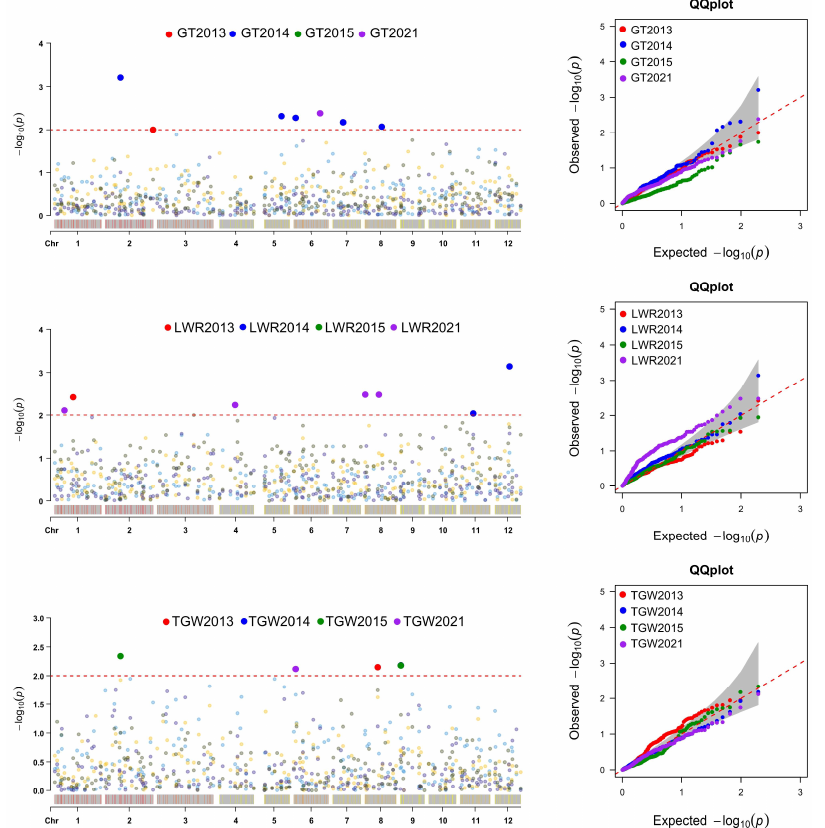
Figure 4. Manhattan plots and quantile–quantile (QQ) plots for grain-size traits based on the MLM model. For the Manhattan plot, the x-axis presents the 12 rice chromosomes and the y-axis the LOD ( − log( p -value)) values. For the QQ plot, the x-axis presents LOD ( − log( p -value)) values and the y-axis the expected LOD ( − log( p -value)) values.